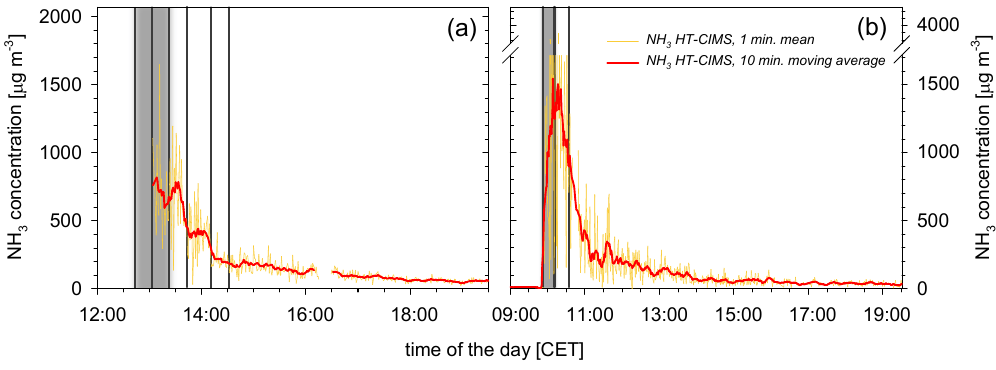
Fig. 3. NH 3 concentrations measured by the HT-CIMS on (a) 4 August 2009 and (b) 6 August 2009; vertical bars represent the spreading of the individual slurry tracks (#1... #6 on 4 August 2009 and #1... #3 on 6 August 2009) while grey shaded areas indicate the period of slurry spreading that mainly affected the fetch of the measurement (Sintermann et al.,